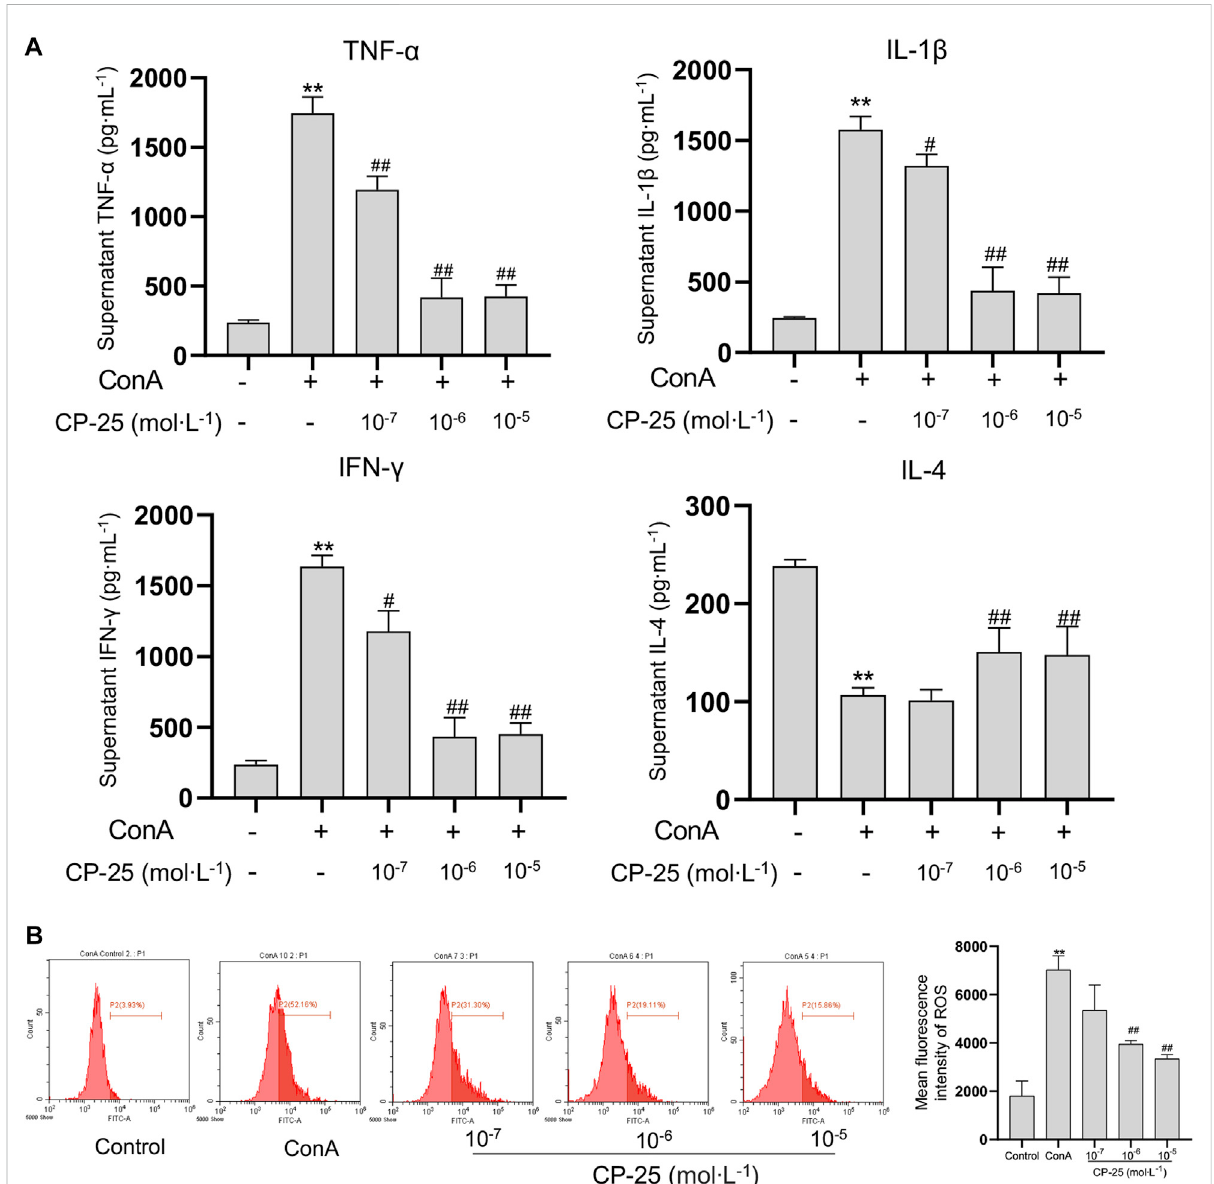
CP-25inhibitedin fl ammatorycytokinesandROSreleaseinRAW264.7cells. (A) Comparisonin fl ammatorycytokinelevelsofTNF- α ,IL-1 β ,IFN- γ and IL-4 in the supernatant of RAW264.7 cells by ELISA. (B) Decreased ROS levels were observed in CP-25 administrated RAW264.7 cells. **p